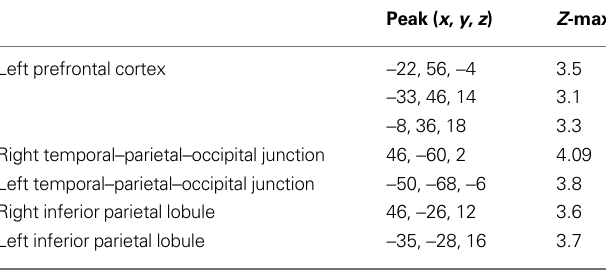
Table 5 | Self-Gain $4 > Charity-Gain $4.